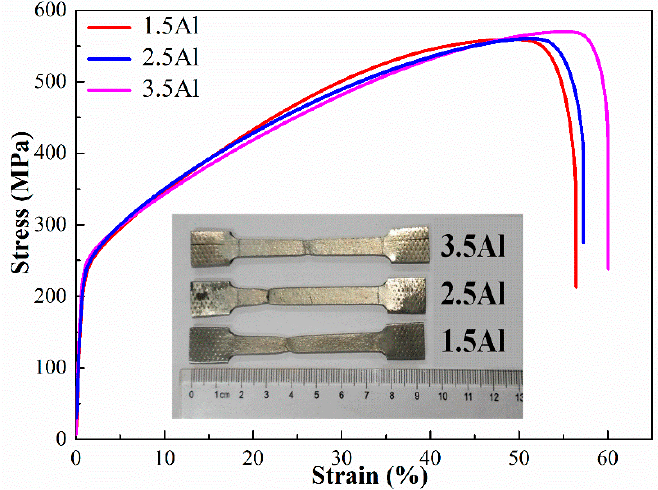
Figure 4. Stress–strain curves of new alumina-forming austenitic heat-resistant steels at room temperature.